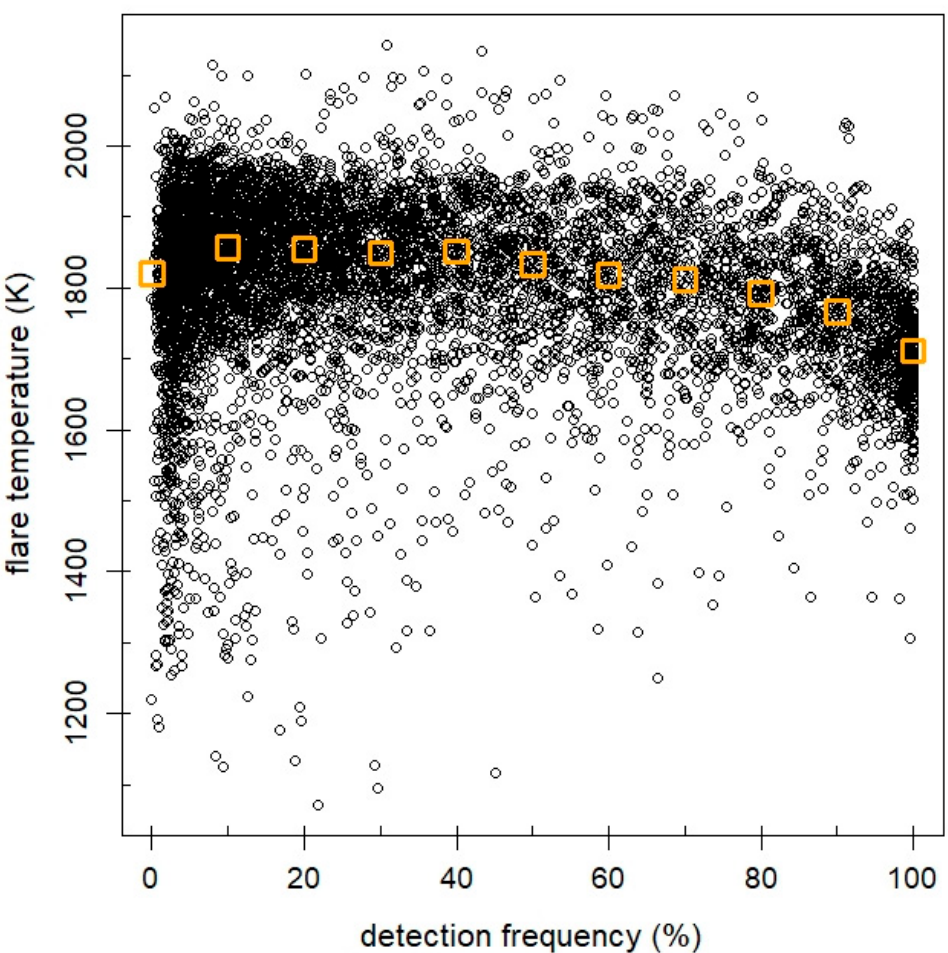
Figure 2. Average flare temperatures as a function of detection frequency (2019 data), illustrating that high detection fre- quencies, associated with the largest estimated flaring volumes (Figure 1b), are related to flares with lower remotely sensed flame temperatures. Orange squares mark 10%-binned (0–5%, 5–15%, 15–25%, etc.), median flare temperatures per detection frequency